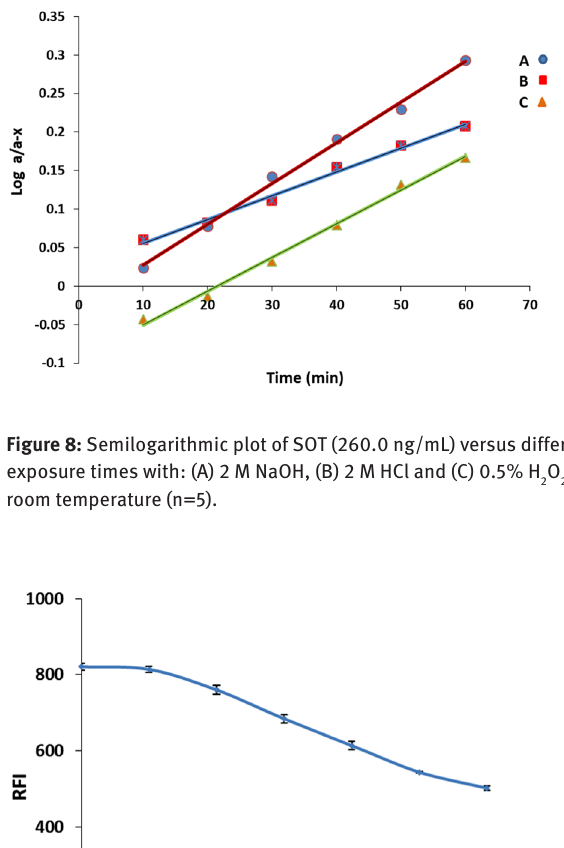
constant (K, min −1 ) 0.012178 56.9 0.007116 97.4 0.010081